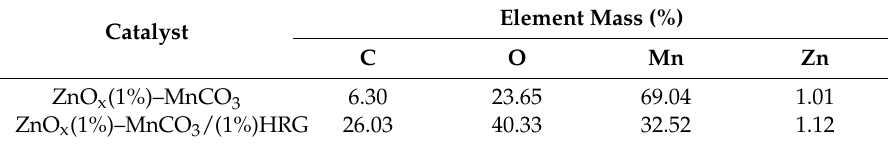
Table 1. Elemental composition of the catalyst ZnO x (1%)–MnCO 3 and ZnO x (1%)–MnCO 3 /(1%)HRG. Element Mass (%) Catalyst